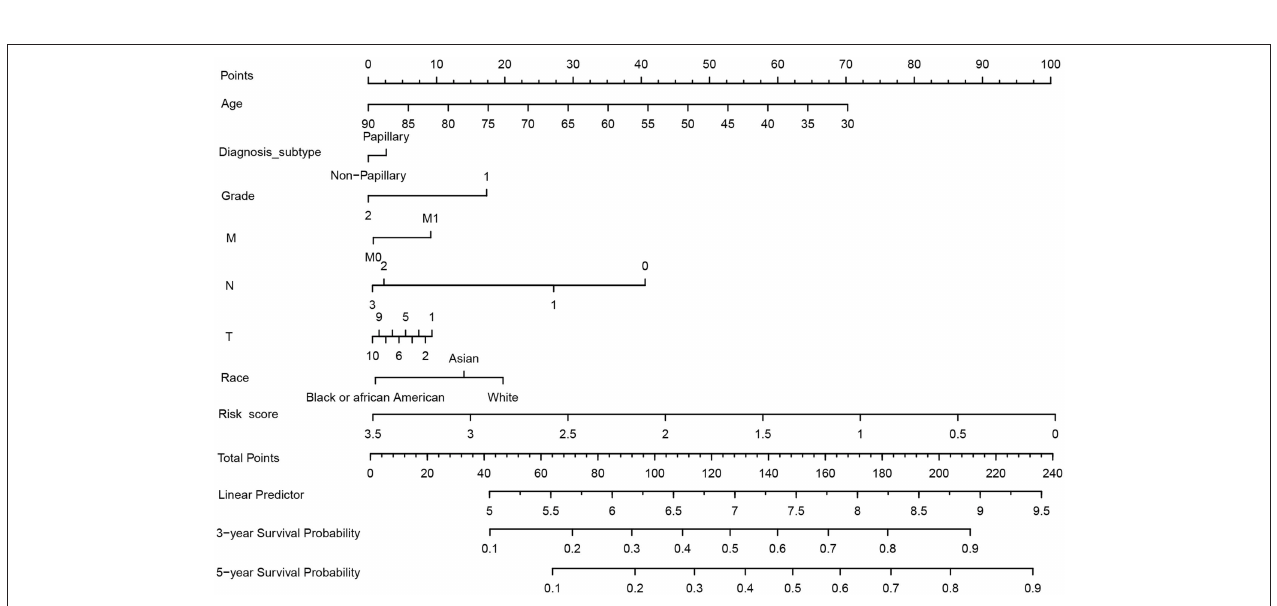
FIGURE 6 | Construction of the 21-miRNA signature based nomogram and its clinical use.